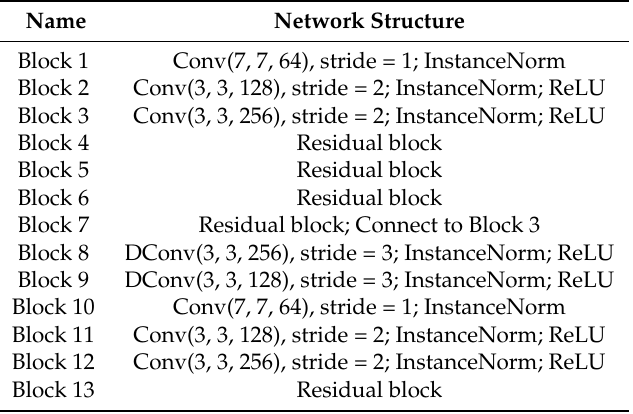
Table 1. Generator